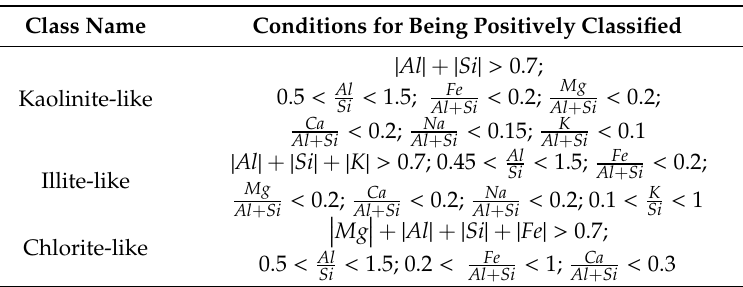
Table 2. Conditions for element-based major clay mineral identification. The element symbols represent the concentration in atom%. All conditions must be met. In addition, a low contribution of sea-salt-a ffi ne elements is required, defined by the additional condition: ( | Na | + | Cl | + 2 | S | ) / ( | Al | + | Si | ) < 0.25. As no structural mineral analysis was carried out, the particle classes are termed ‘-like’ to express the similarity in chemical